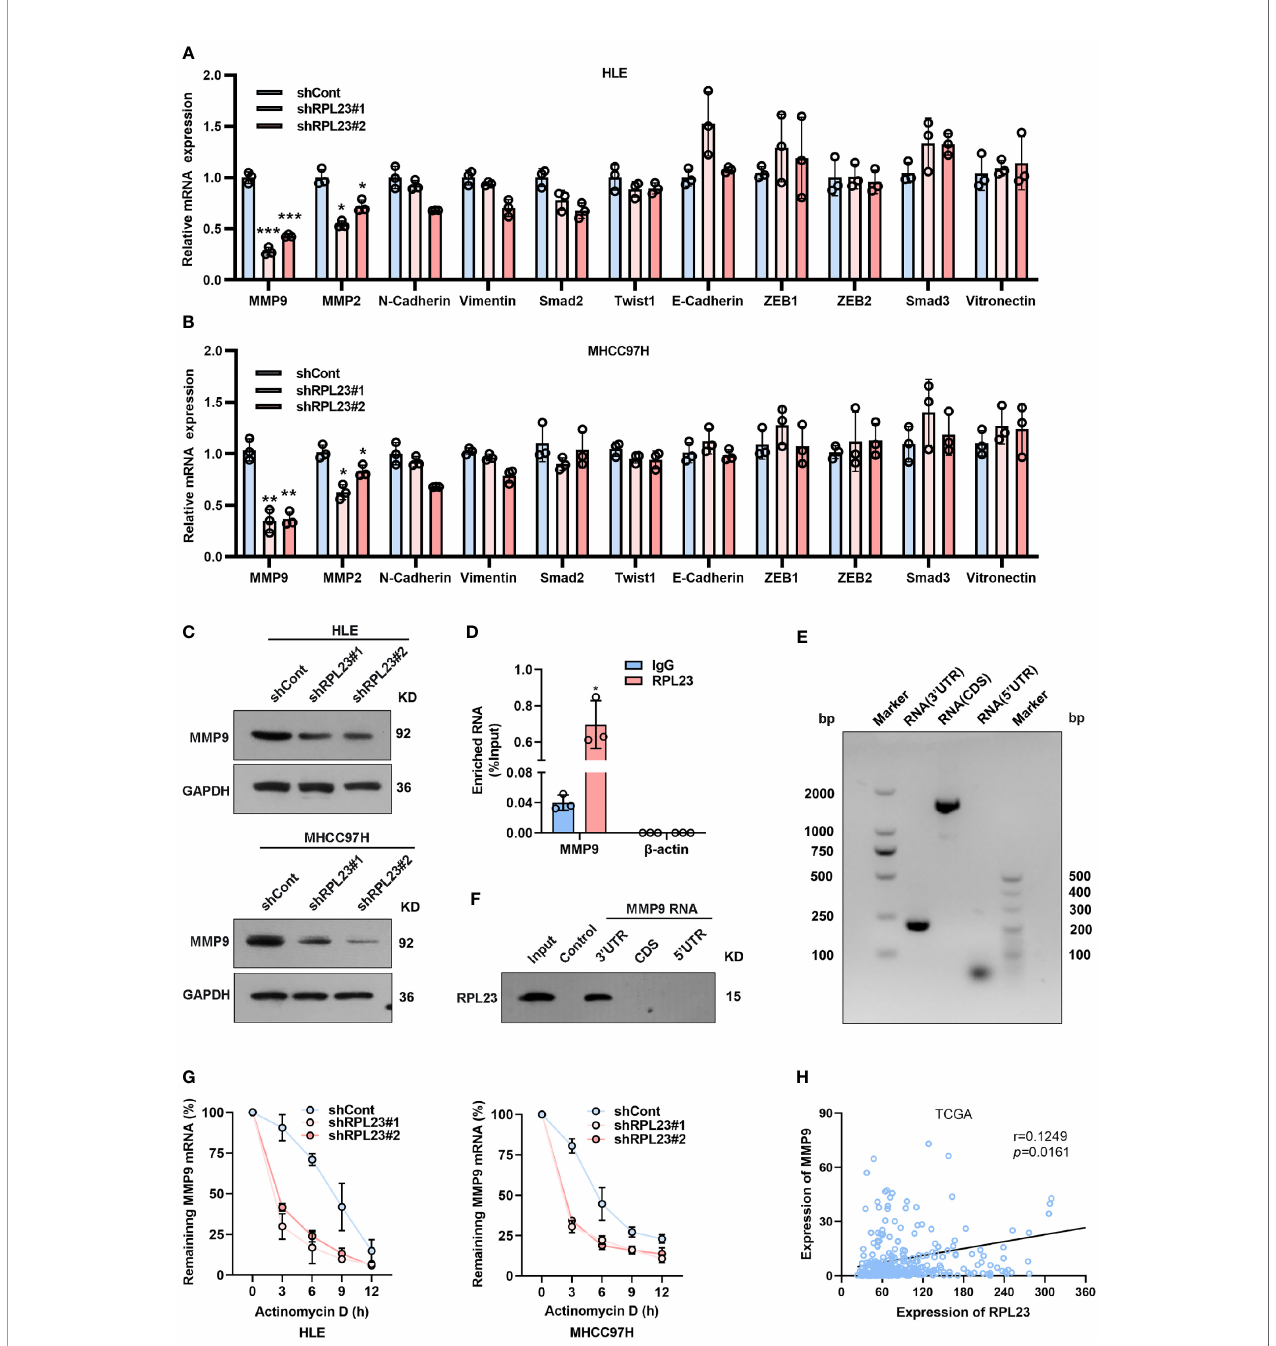
FIGURE 5 | MMP9 is an essential downstream effector of RPL23. (A, B) EMT-related markers (MMP9, MMP2, N-cadherin, Vimentin, Smad2, Twist1 and E- cadherin) were measured on RPL23-depleted HCC cells by qRT-PCR. b -actin was used as an internal quantitative control. (***p < 0.001) (C) RPL23 regulated MMP9 protein expression in HLE and MHCC97H cells measured by western blot assay. GAPDH was used as a loading control for western blotting. (D) RIP assays showed that RPL23 directly bound to MMP9 mRNA. (E, F) RNA pull-down results showed that RPL23 was directly associated with the 3`UTR of MMP9 mRNA. (E) shows the biotinylated-MMP9-3 ’ UTR, CDS or 5 ’ UTR transcript in vitro , (F) shows the result of the RNA pull-down assay as analyzed by western blot. Control indicates a control pulldown containing beads only. (G) The half-life of MMP-9 mRNA was reduced after RPL23 knockdown in HLE and MHCC97H cells followed by treatment with 5ug/mL actinomycin D at the indicated times. Error bars represent SEM. p-values (HLE): **p = 0.00116 (shCont vs shRPL23#1), **p = 0.00296 (shCont vs shRPL23#2). p-values (MHCC97H): **p = 0.00314 (shCont vs shRPL23#1), **p = 0.00477 (shCont vs shRPL23#2). (H) Scatter plot between RPL23 and MMP9 mRNA level in HCC (n = 371, from TCGA database). Spearman ’ s correlation coef fi cients were calculated. Representative data are from at least three independent experiments. *p<0.05, **P < 0.01, ***P <